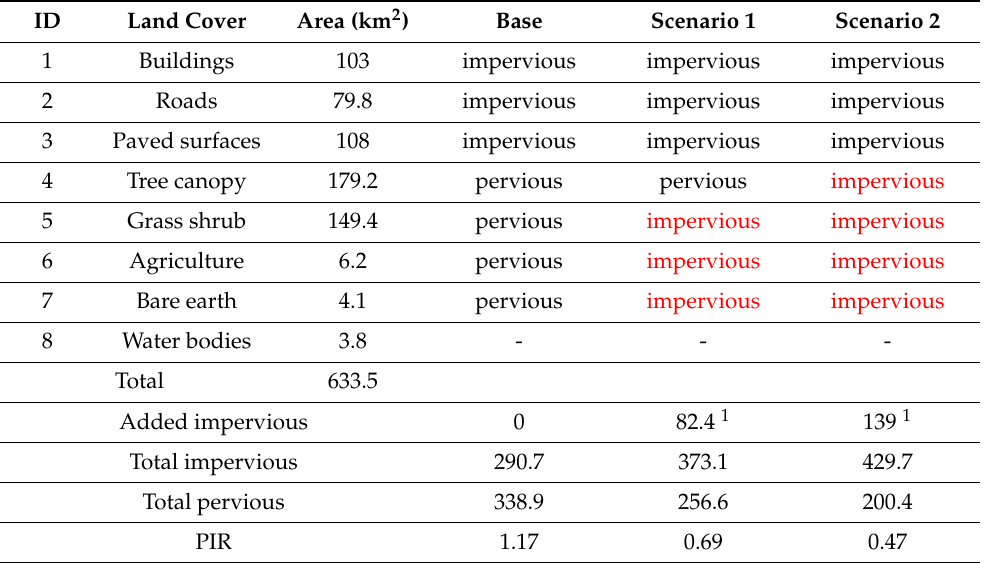
Table 4. Land cover data of Toronto at the year 2007 and its projected changes due to the urban growth for two scenarios.